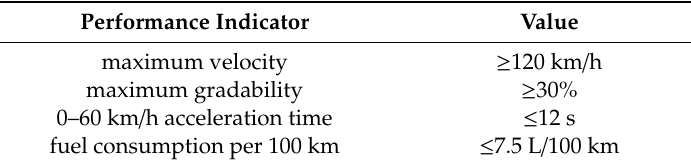
Table 2. Vehicle performance